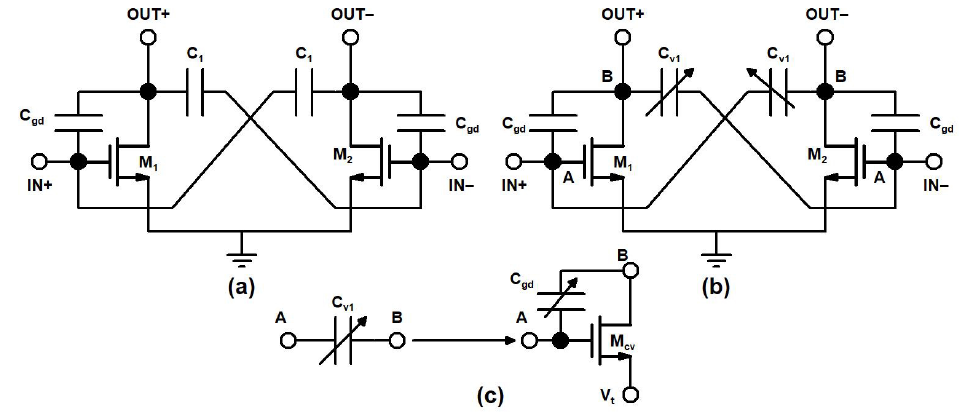
Figure 5. ( a ) Conventional capacitive cross-coupling neutralization, ( b ) TCC-CS and ( c ) varactor realization in